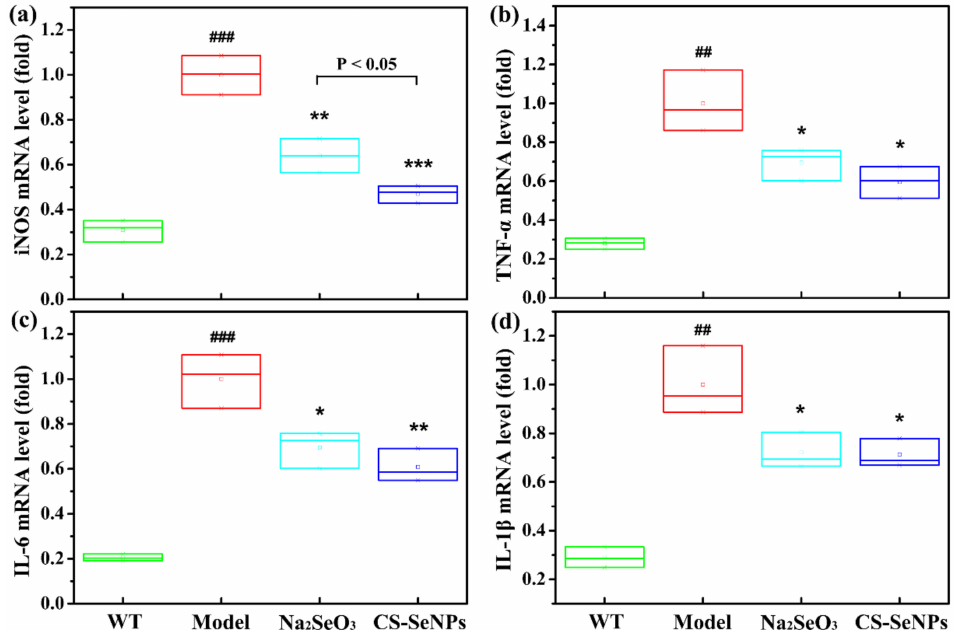
Figure 9. CS-SeNPs and Na 2 SeO 3 inhibited the inflammatory response induced by LPS in ECs. Cells were induced with 1 µ g/mL LPS for 12 h alone or pretreated with 0.5 µ M CS-SeNPs or Na 2 SeO 3 for 12 h before exposure to LPS. The mRNA expression levels of iNOS ( a ), TNF- α ( b ), IL-6 ( c ) and IL-1 β ( d ) were assayed by qPCR. The results were ex-pressed as mean ± SD ( n = 3). ## p < 0.01, ### p < 0.001, compared with control cells (Con). * p < 0.05, ** p < 0.01, *** p < 0.001, compared with cells treated with LPS